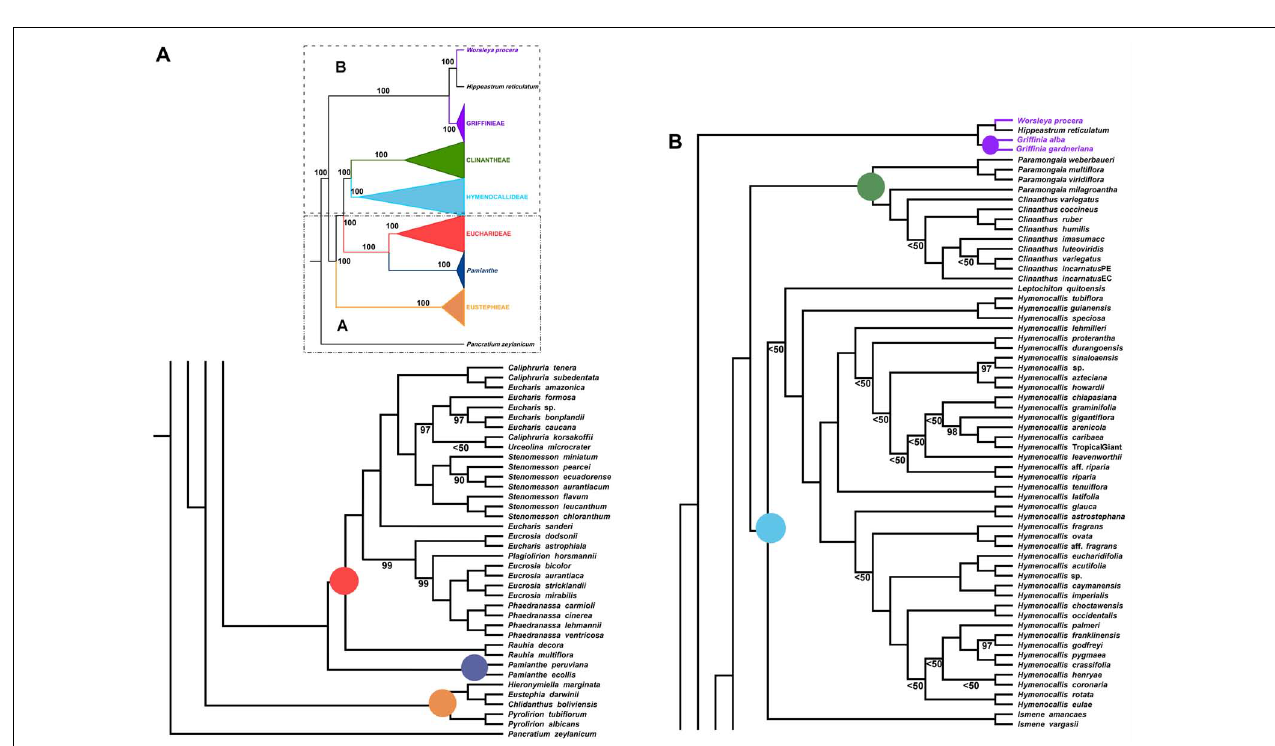
FIGURE 4 | Best tree from maximum likelihood analysis of partial plastome sequences across the Andean tetraploid clade of Amaryllidaceae subfam. Amaryllidoideae, with bootstrap percentages < 100 shown above branches (all unmarked branches have 100% BP). The tree is divided into two sections (A,B) for readability; refer to the colored inset (a cartoon of the tree collapsed to the tribal level) as a guide. Colored circles at the nodes in the full tree conform to clade colors in the